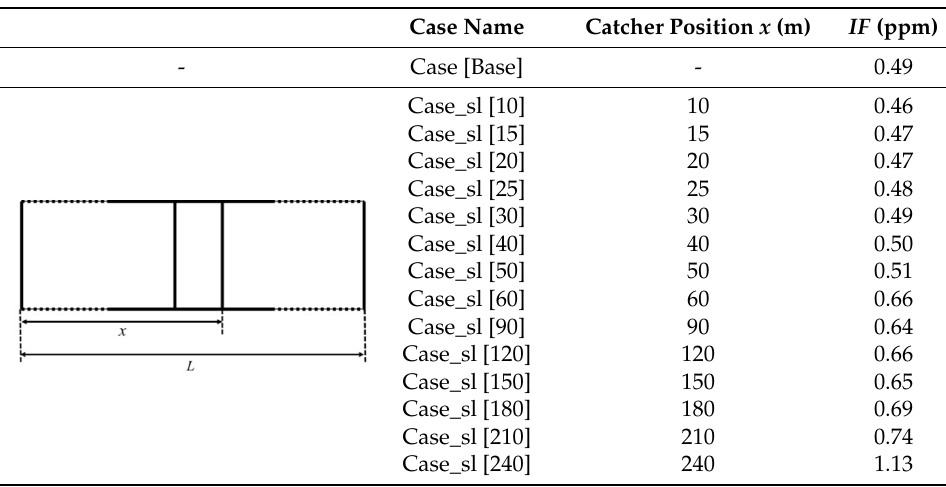
Table 4. Intake Fraction ( IF ) in cases with a single long catcher.